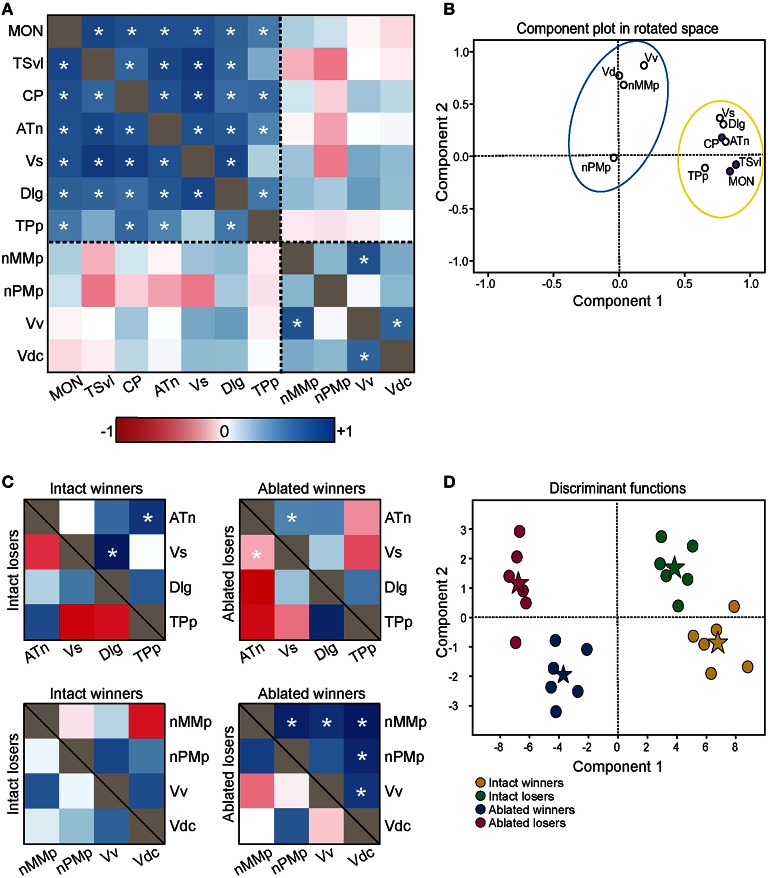
Lateral line-ablated animals have altered co-activation of functional networks within the SDMN. (A) Heat map of Pearson correlation coefficients (R = color scale) of cfos staining in brain nuclei correlated with other nuclei (N = 24 animals per region; See also Table 2). Dashed lines separate the two functional networks. (B) Principal component analysis of cfos staining in sensory processing (purple dots) and social behavior (white dots) brain nuclei reveal two distinct networks. Dashed circle encompasses network that incorporates mechanosensory cues, and solid circle encompasses second network without lateral line input. (C) Heat maps of Pearson correlation coefficients of two functional networks within the SDMN (N = 6 animals per group). Top two boxes represent network 1 (SDMN nuclei that receive lateral line input) with winners above the black line and losers below. Bottom two boxes represent network 2 (other SDMN nuclei). (D) Discriminant function analysis distinguished lateral line-intact fight winners (yellow) and losers (green) from lateral line-ablated fight winners (blue) and losers (pink). Stars represent each group centroid. *P < 0.05 on heat maps. See list for abbreviations.